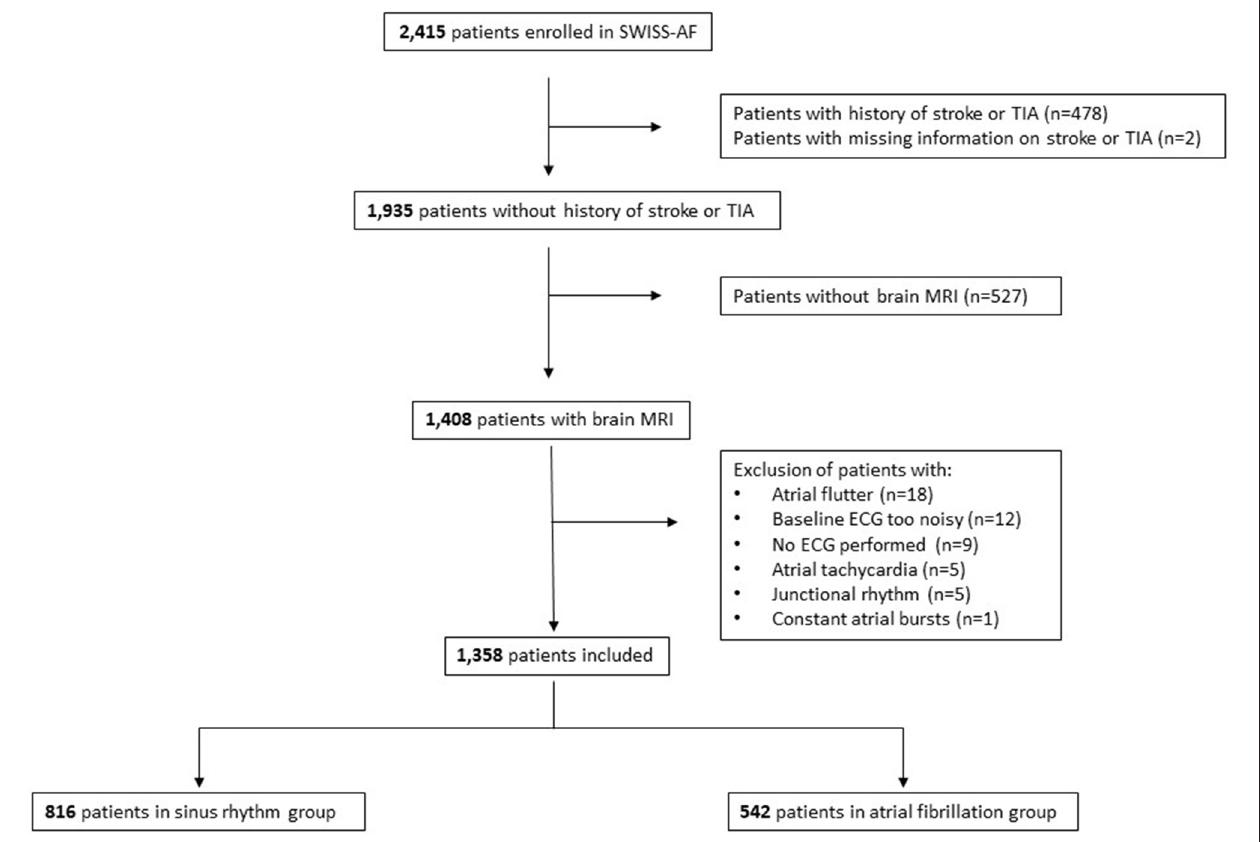
FIGURE 1 | Flow chart of patient